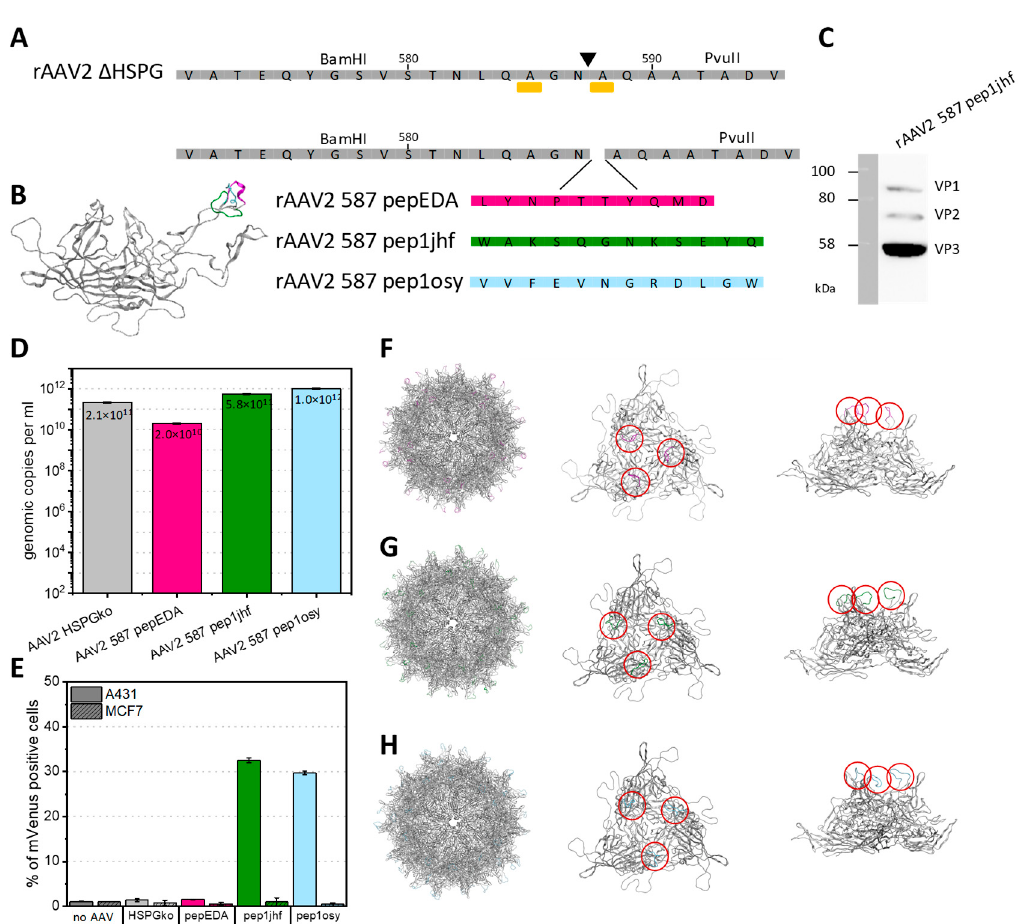
Figure 4. Insertion of peptides at residue 587 into AAV2 VP2 and production and transduction. ( A ) VP protein as illustrated by Chimera from PDB 1LP3 and amino acid sequences of VP with mutations R585A and R588A (yellow sidechain, bar under sequence) and corresponding restriction sites BamHI and PvuII enabling respective genetic modifications. ( B ) Superimposition of VP3 monomers of AAV2 showing all peptide modifications in the 587 position. ( C ) Western blot analysis of recombinant adeno-associated virus (rAAV2) 587 pep1jhf showing the presence of all three VP proteins after incubation with the anti-VP antibody B1 (Progen). Full raw images are given in Figure S27. ( D ) E ff ects of peptide integration on production yield. rAAVs were produced in a triple-transfection HEK293 system. Viral particles were purified using iodixanol gradients and DNaseI-resistant genomic copies were quantified via qPCR against plasmid standards and are presented as genomic copies per ml. Error bars represent mean ± SD for two replicates. ( E ) Quantification of mVenus-positive A431 or MCF7 cells transduced with mVenus-gene carrying rAAV presenting the peptide indicated in the category axis at a multiplicity of infection (MOI) of 50,000. mVenus expression levels of biological duplicates were analyzed 96 h post transduction by flow cytometry. Error bars represent mean ± SD for two replicates. Pep1osy- and pep1jhf-carrying AAV2 show an enhanced transduction of EGFR-expressing cells. ( F – H ) Capsid structure, side-view, and view along the threefold symmetry axis of the trimer for pepEDA ( F ), pep1jhf ( G ), and pep1osy ( H ). Structural calculations were performed using the SWISS-MODEL online tool (https://swissmodel.expasy.org/) and were visualized using PyMol. Red circles highlight the positions of the peptides within the trimer.